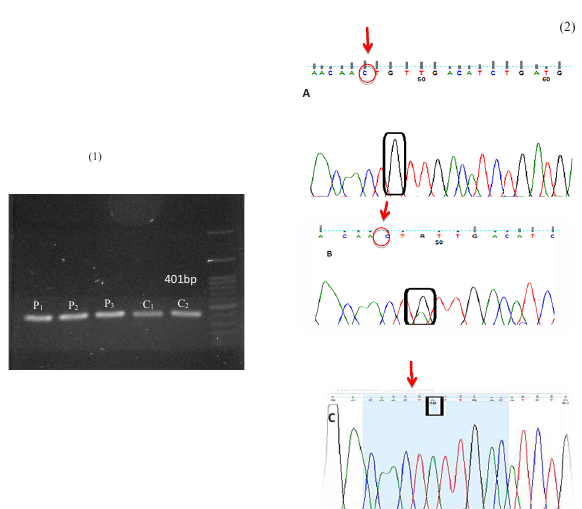
Figure 1. ( 1) Agarose gel Electrophoresis for PCR Amplification of NEFH Gene. (DNA ladder (100bp); lane P 1 , P 2, and P 3 represent case; lane C 1 and C2 represent healthy control individuals), ( 2) Results of Direct Sequencing of NEFH Gene. (A: Homozygote healthy mode, B: Heterozygote state, C: Homozygous patients)